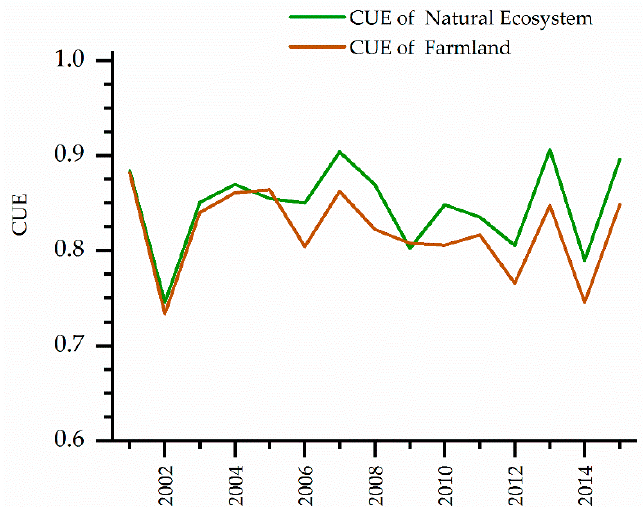
Figure 15. Average CUE variations of natural ecosystems and farmland in the SNP from 2001 to 2015.